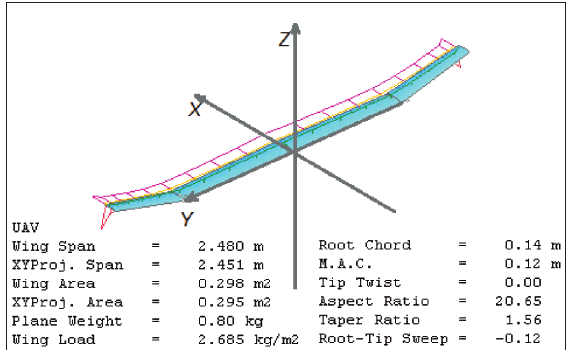
Fig. 1. Aircraft data and coordinate